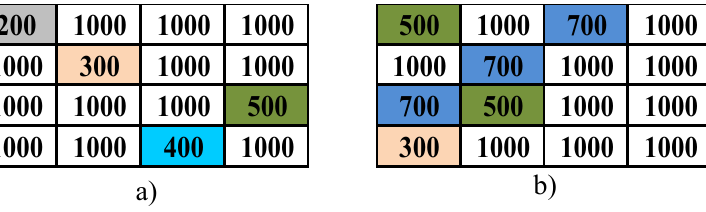
Figure 10. PSC before reconfiguration ( a ) case I, ( b ) case II.